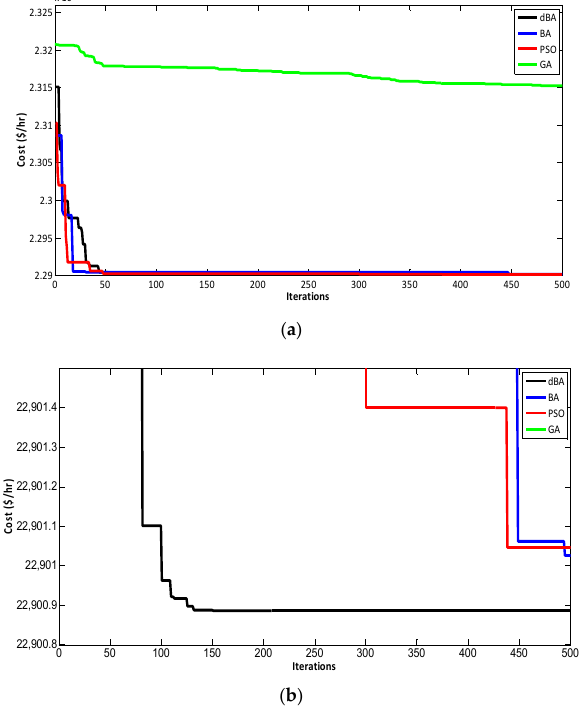
Figure 11. Convergence curve: ( a ) Convergence graphs with renewables; ( b ) Magnified view.